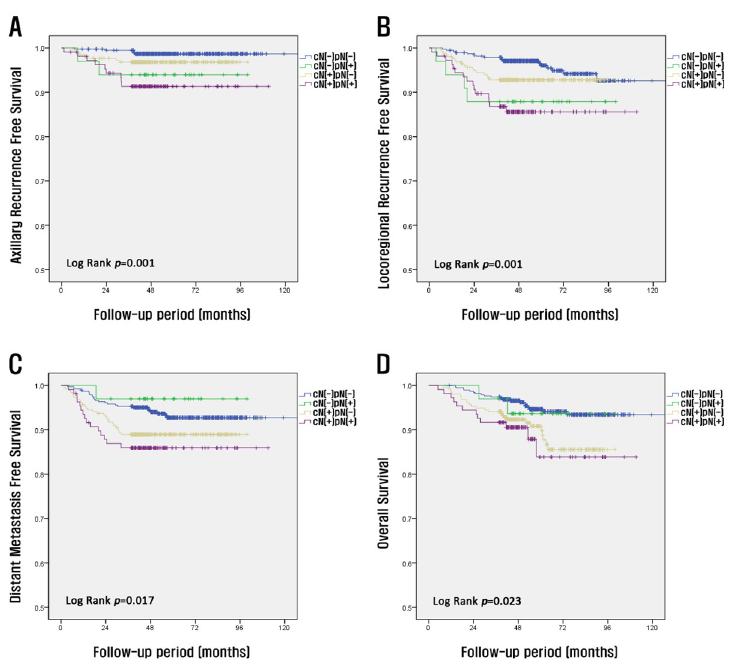
Fig 3. Kaplan–Meier curves according to patients’ clinical and pathological nodal status. Axillary recurrence-free survival (A), locoregional recurrence-free survival (B), distant metastasis-free survival (C), and overall survival (D).